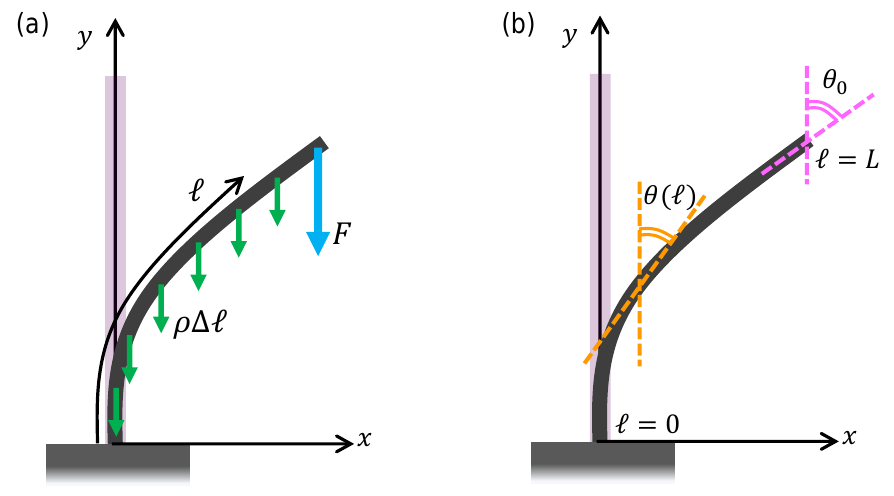
Figure 1. Configuration diagram of a column under combined loads: ( a ) Concentrated load F at the tip and uniformly distributed load ρ caused by the self-weight per length. ( b ) Tilt angle θ ( (cid:96) ) and tip angle θ 0 at (cid:96) = L